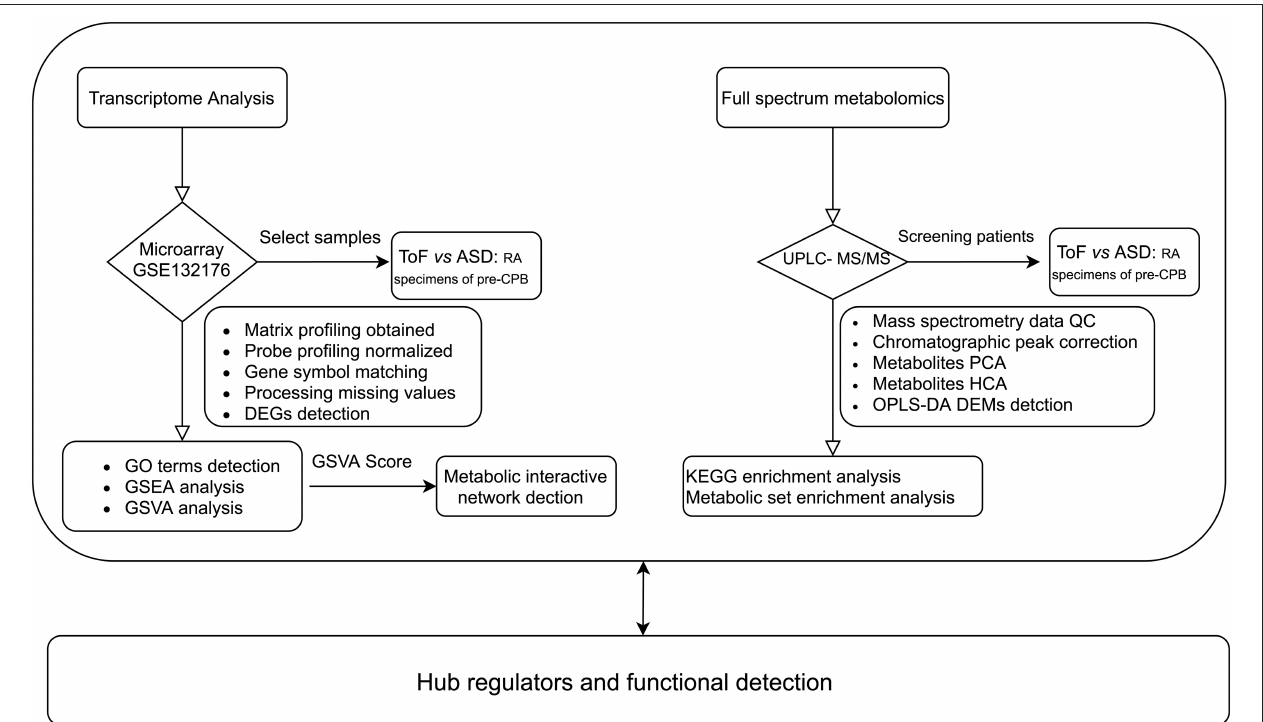
FIGURE 1 | Workflow of metabolic reprogramming